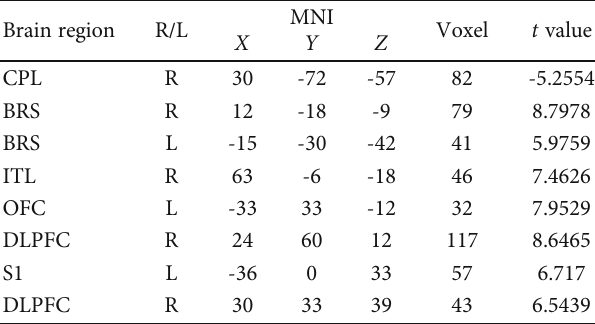
Figure 8: Regions showing signi fi cantly di ff erent EC with the rACC in placebo status (IG) compared with placebo status (EG). Table 5: Locations of the regions showing signi fi cantly altered EC with the rACC in nocebo status compared with pain status in IG ( p < 0 : 05 , FDR < 0 : 05